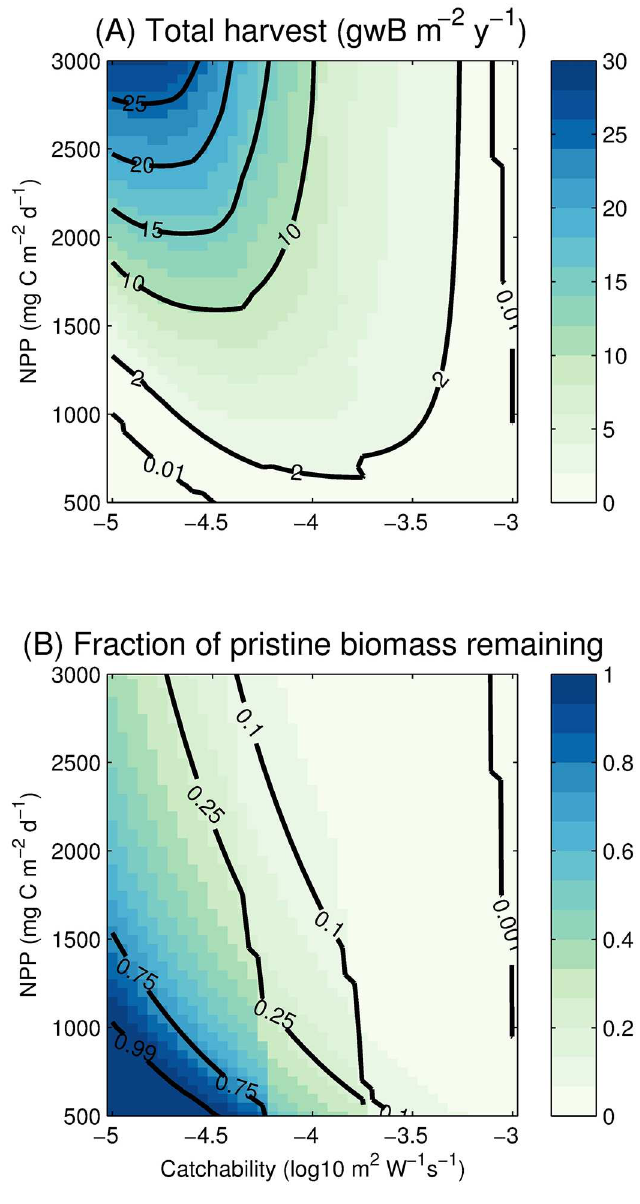
Fig 8. Model sensitivity to NPP and catchability q . (A) Total harvest and (B) Fraction of pristine biomass remaining as functions of NPP and q